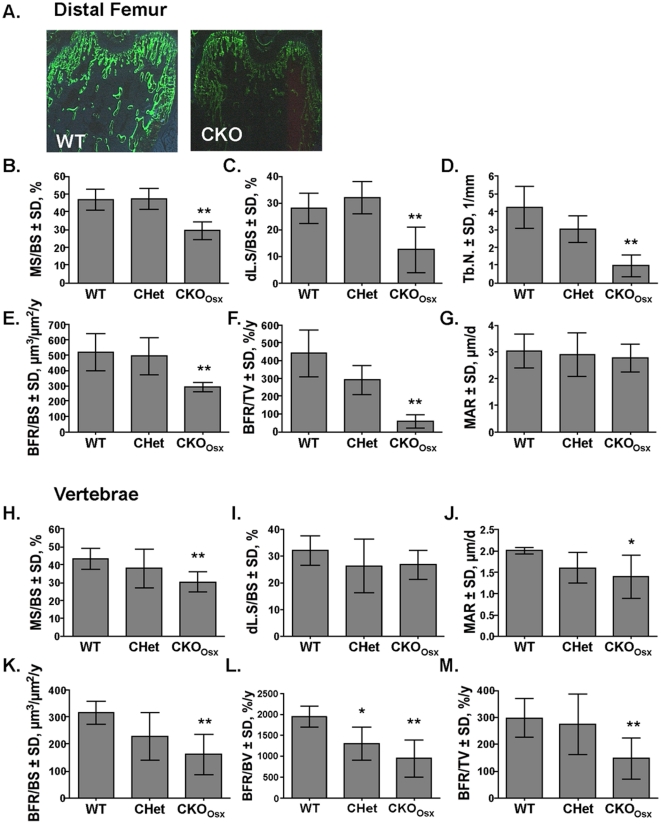
Trabecular bone formation rates are lower in Hdac3 CKO mice.A Fluorochrome incorporation in the trabeculi of distal femurs is decreased in CKO mice. Newly formed trabecular bone in distal femurs (B–G) and vertebrae (H–M) was assessed in 5.5 week old male mice following two calcein injections using Osteometrics™ software. (n = 5), *p<0.05, **p≤0.01.